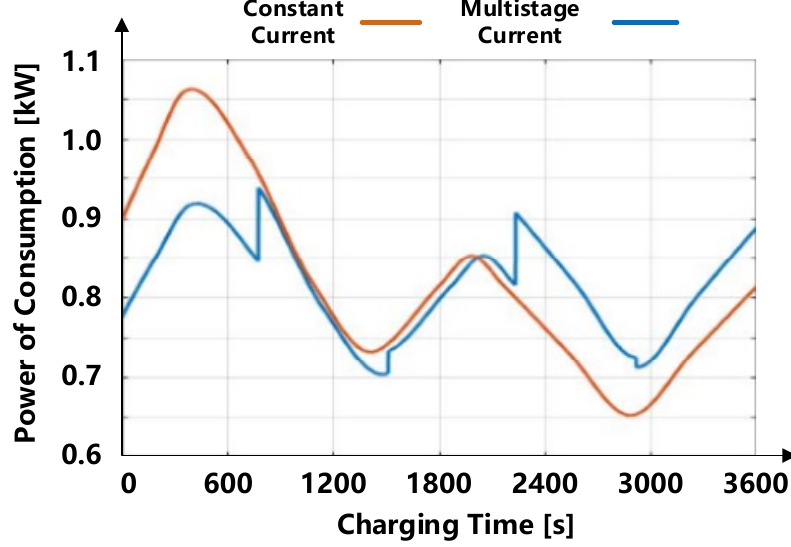
Figure 12. SOC of multistage current and constant current charging method of one battery in SM of phase A.